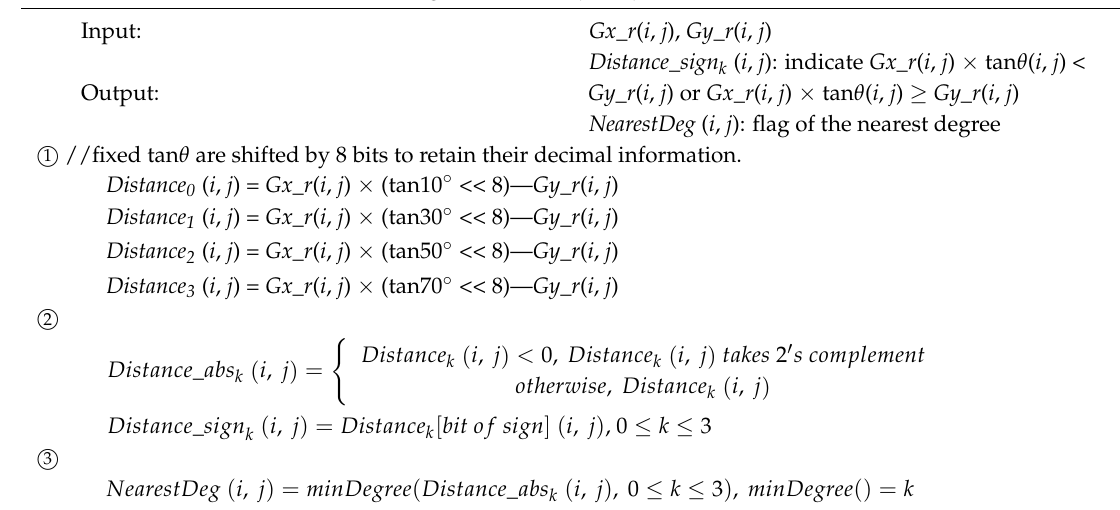
Algorithm 2. Determine the nearest tangent value of Gy_r ( i , j